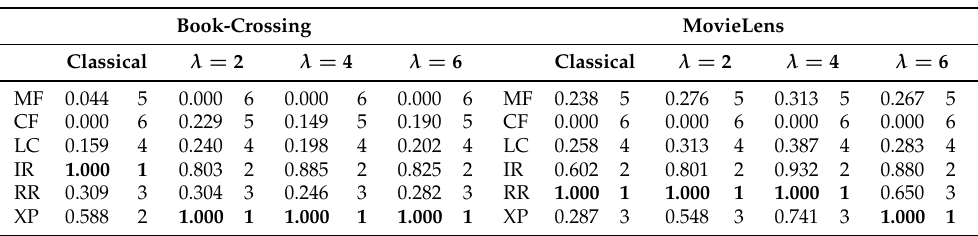
Table 5. Evolution of the novelty scores (i.e., computed as the (renormalized) average of the scores of all variants of the EPC scores) of the various algorithms when comparing a classical random 10-fold bootstrap process (see the columns “Classical”) and our new framework (see the columns λ = 2, λ = 4and λ = 6). The left part of each column contains the normalized score (on the six rows of the column), while its right part contains the rank (from 1 to 6) of the algorithm (on the six rows of the